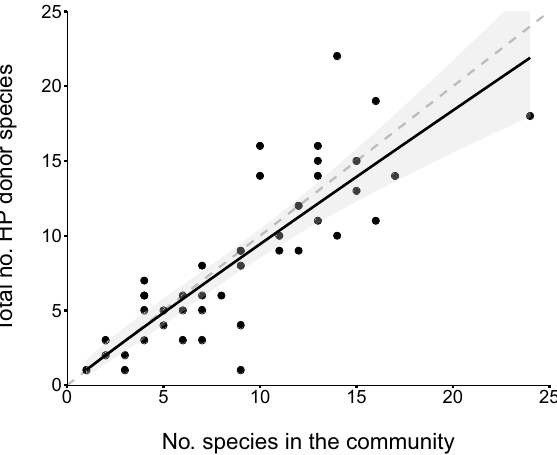
Figure 3. Number of distinct heterospecific pollen (HP) donor species found across all sampled stigmas in a community at a given sampling date as a function of the number of co-flowering plant species. Model predicted values (solid line) with 95% confidence intervals (shaded area) are shown. The dashed line (intercept = 0 and slope = 1) represents the theoretical expectation of the total cumulative number of pollen donor species being equal to the number of plant species in bloom in the